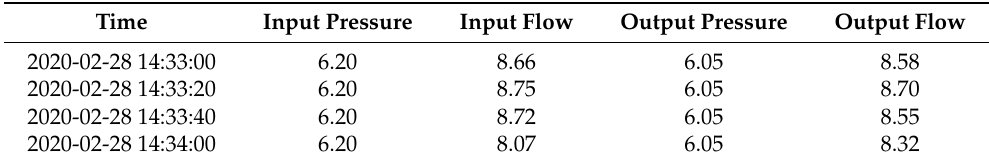
Table 1. Instances of the collected data of pipeline input and output